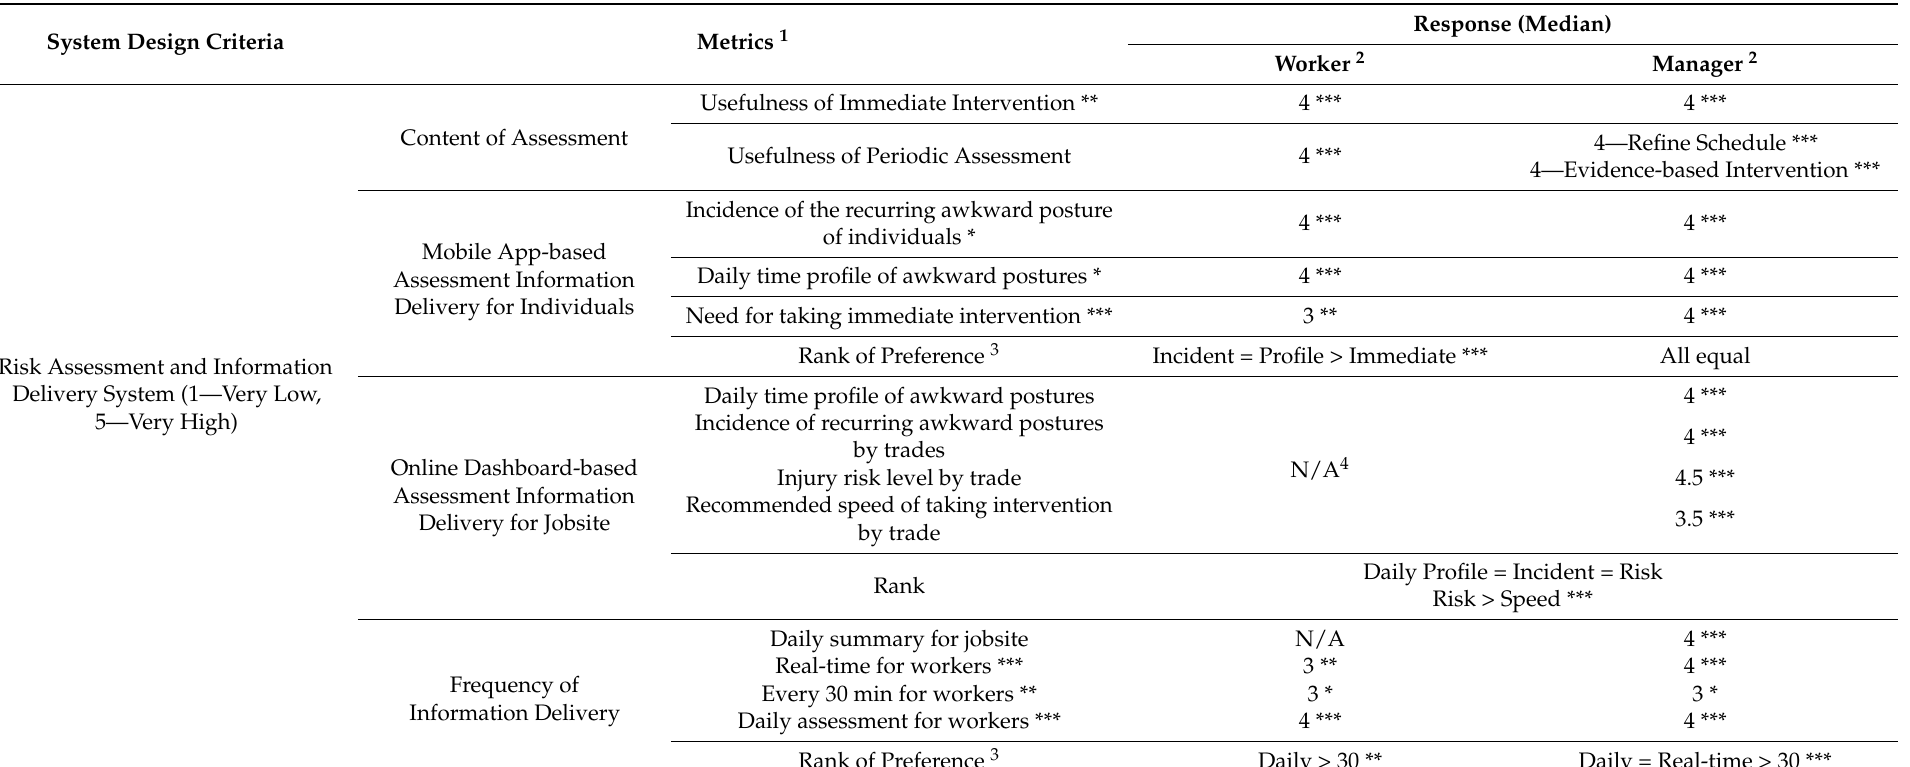
Table 6. Evaluation of risk assessment information and UI for information